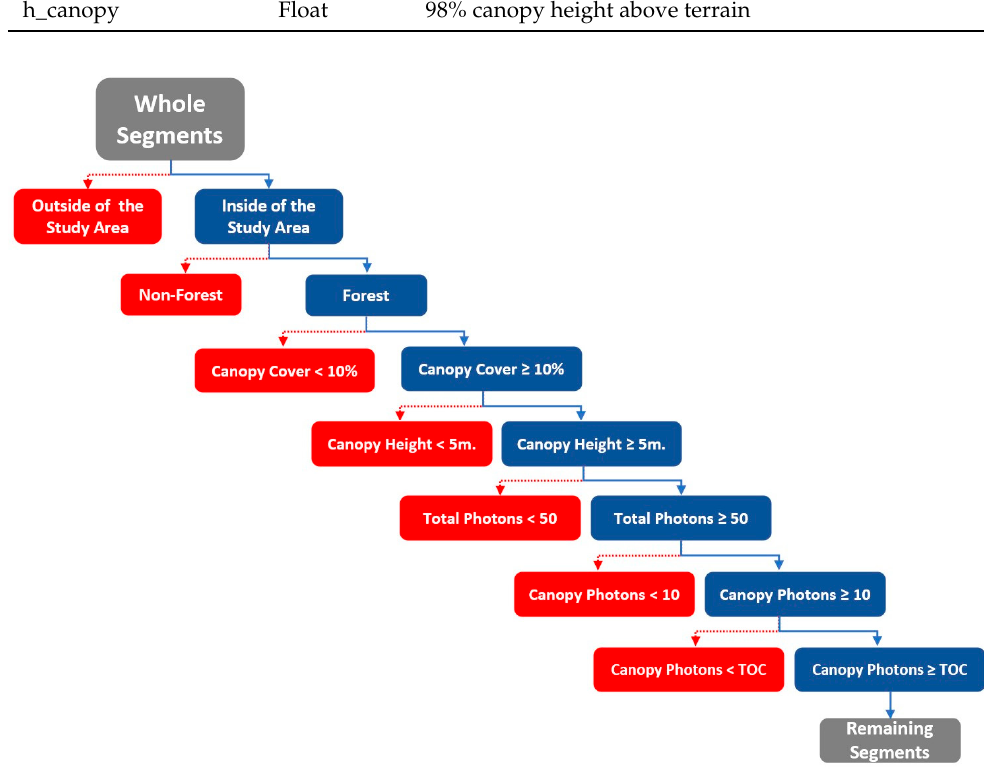
Figure 2. The flow chart depicts the filtering process of ATL08 segments, where red boxes represent filtered segments and blue boxes represent the remaining segments.